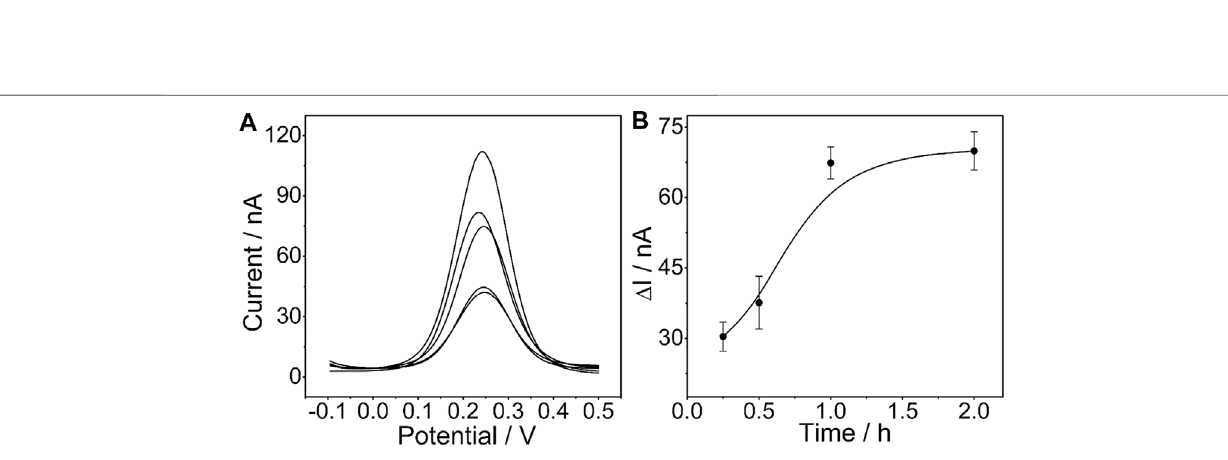
FIGURE4|(A) SWVcurveofthePt μ E/Auelectrodesincubatedwith10 – 7 MCEAaptamersfor(a)withouttheCEAaptamer,(b)0.25h,(c)0.5h,(d)1h,and(e)2h; (B) SWV calibration plot of Pt μ E/Au electrodes incubated with 10 – 7 M CEA aptamer for a different time from 0.25 to 2 h.